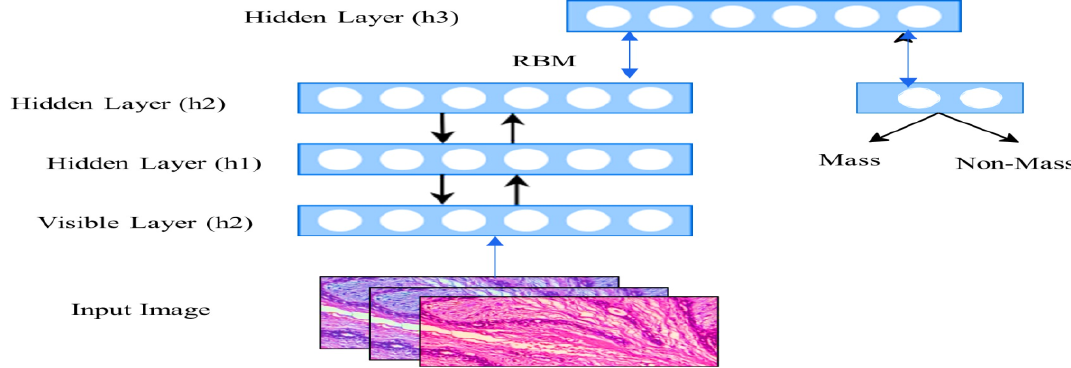
Figure 1. An illustration of the DBN for breast cancer detection.